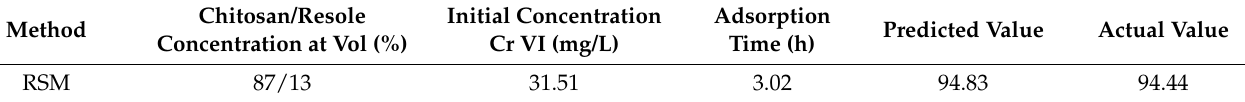
Table 6. Optimal values for RSM